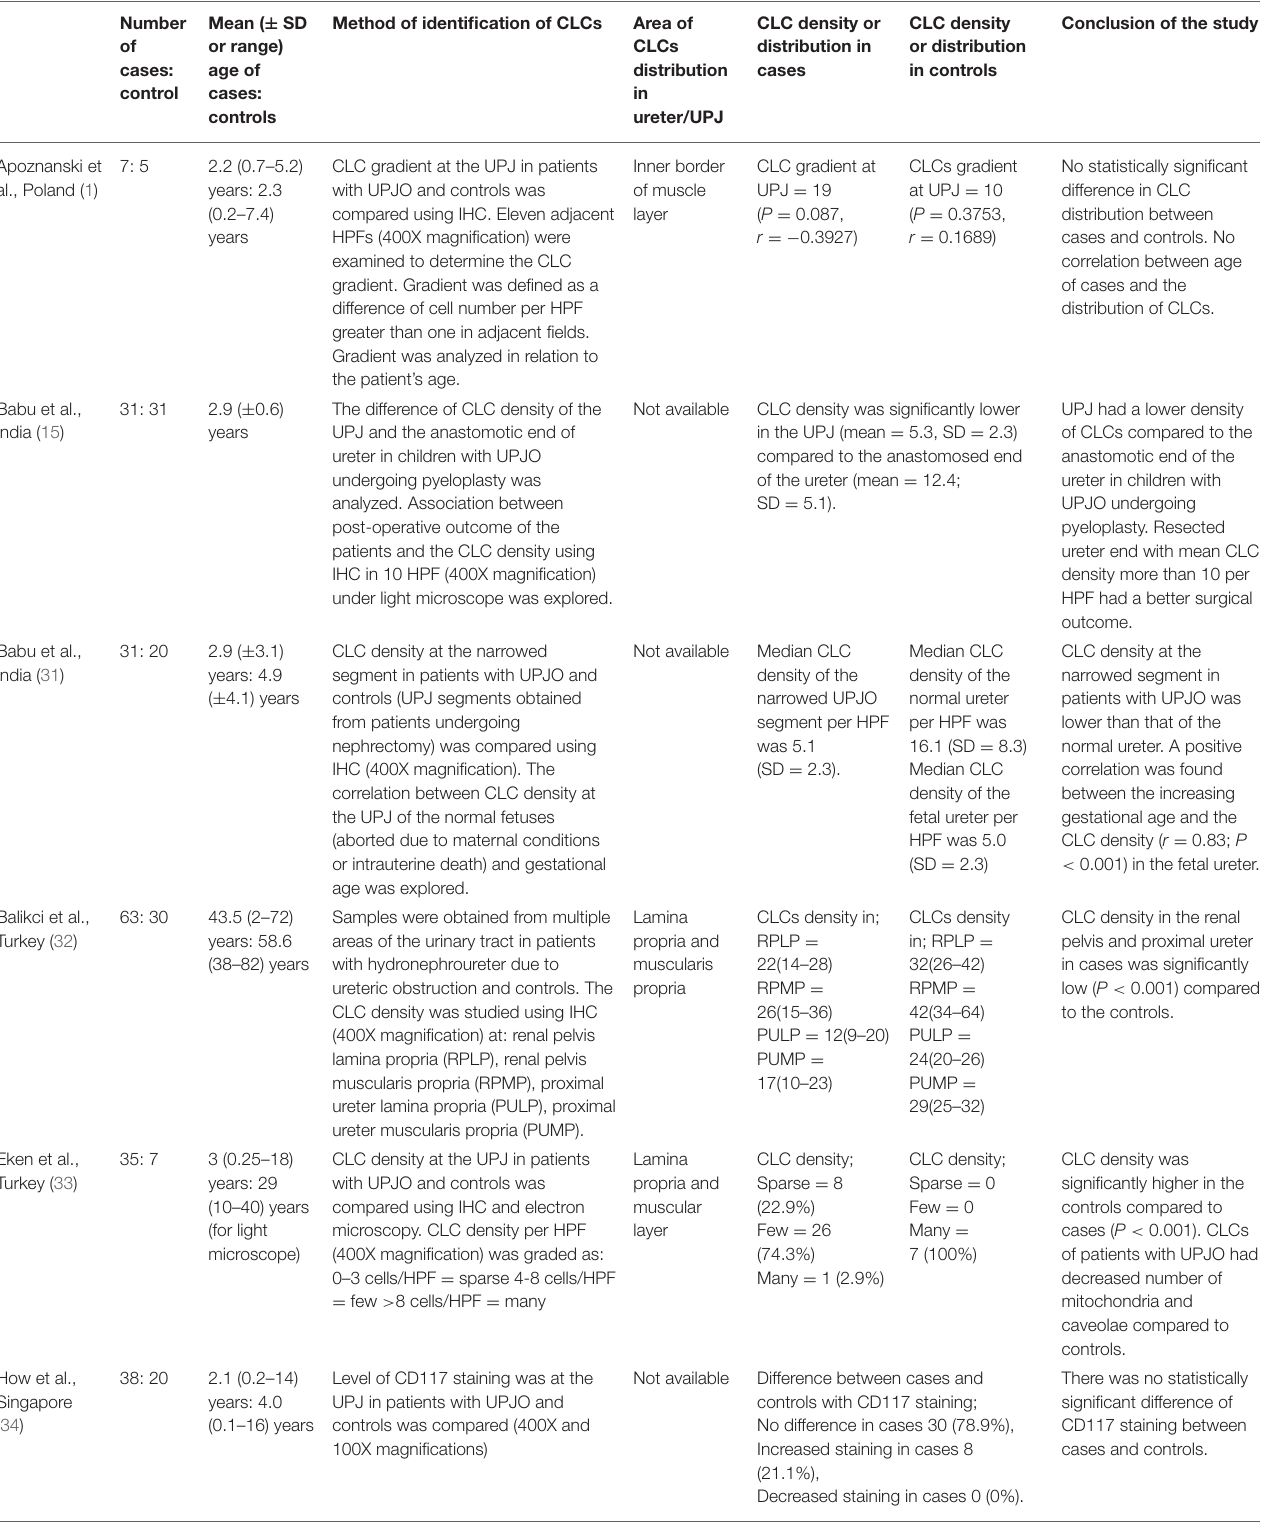
TABLE 2 | Summary of the studies included in the qualitative